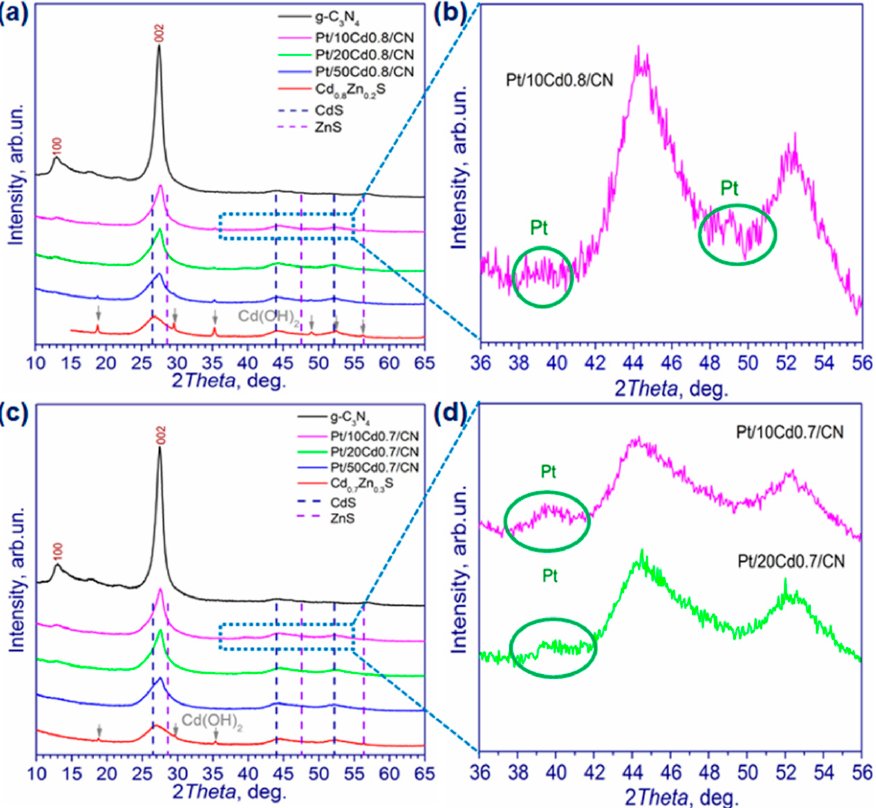
Figure 1. XRD patterns of the photocatalysts based on Cd 0.8 Zn 0.2 S/g-C 3 N 4 ( a , b ) and Cd 0.7 Zn 0.3 S/g- C 3 N 4 ( c , d ).